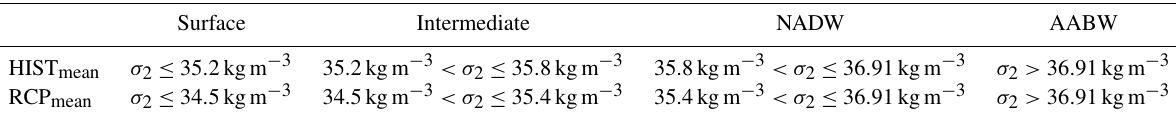
Figure A3. Contributions to the total OHT seasonal cycle from the temperature transport (PWT) of individual water masses calculated in potential density classes in the historical simulation (left) and RCP 8.5 (right): (a–b) total OHT, (c–d) surface layer, (e–f) intermediate layer, (g–h) NADW and (i–j) AABW. Shown are anomalies relative to the annual mean at every latitude. Contour interval is 0.02PWT. Table A1. Definition of water